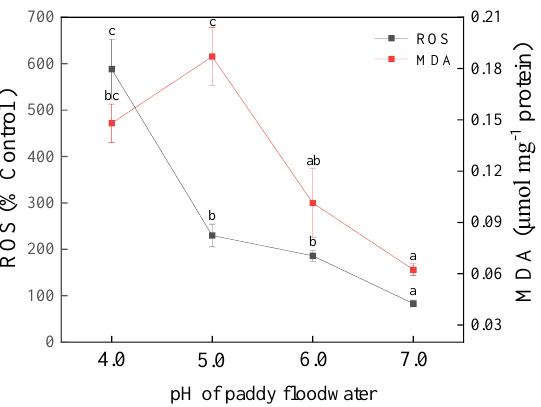
Figure 8. Effect of paddy floodwater acidification on the contents of cellular ROS and MDA of Aliinostoc sp. YYLX235. Different letters indicate statistically significant at p < 0.05 (one-way ANOVA, LSD).